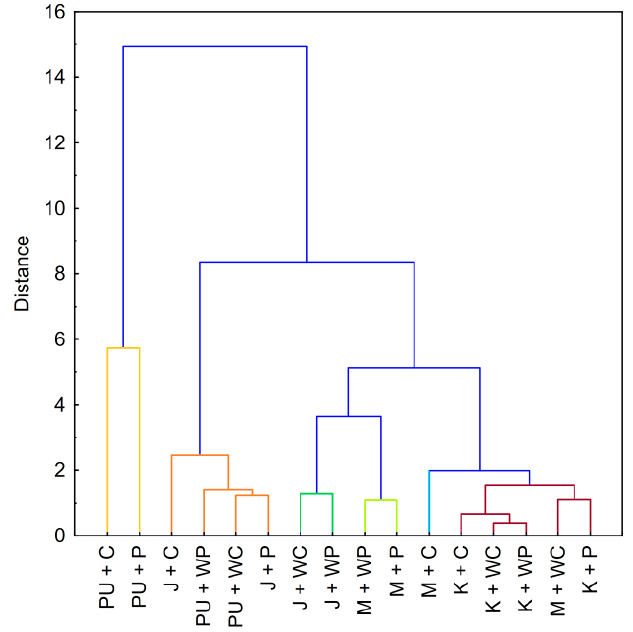
Figure 7. Dendrogram of hierarchical cluster analysis of food products thickened with native starch